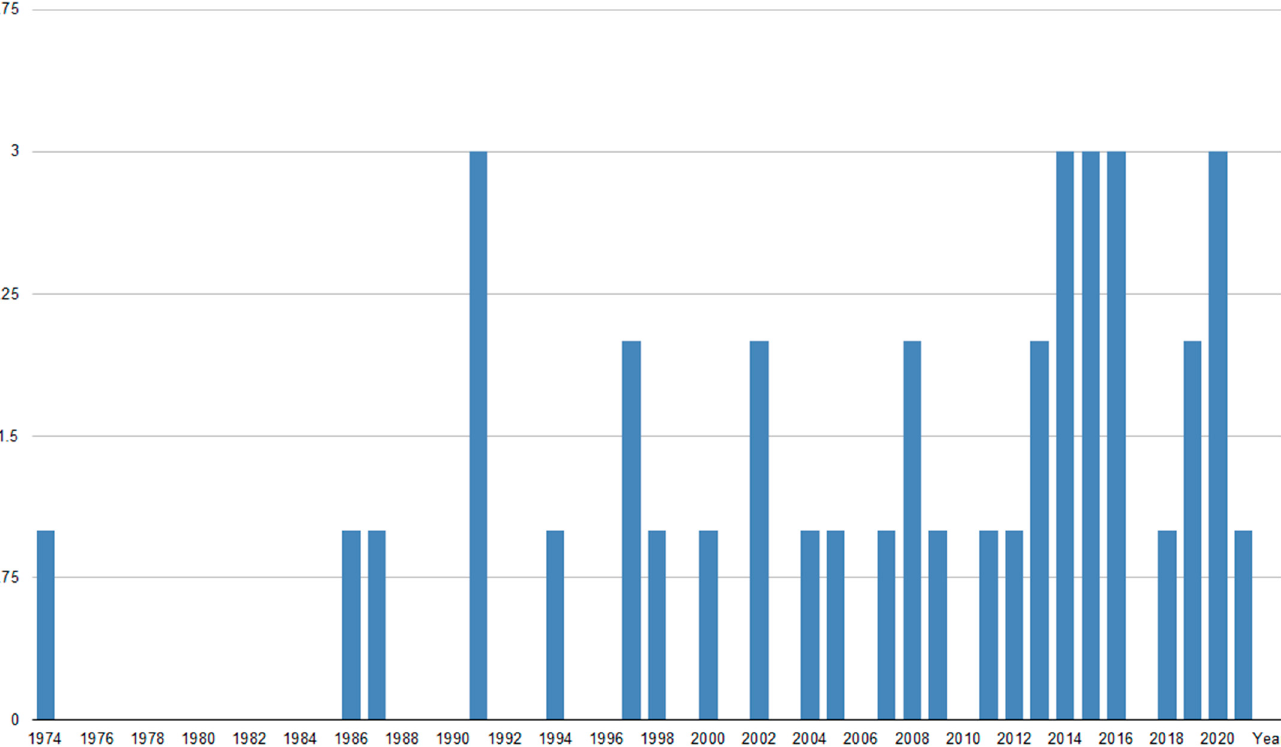
Figure 2. The number of original publications per year on radiotherapy for leptomeningeal carcino- matosis in breast cancer (Pubmed.gov database).